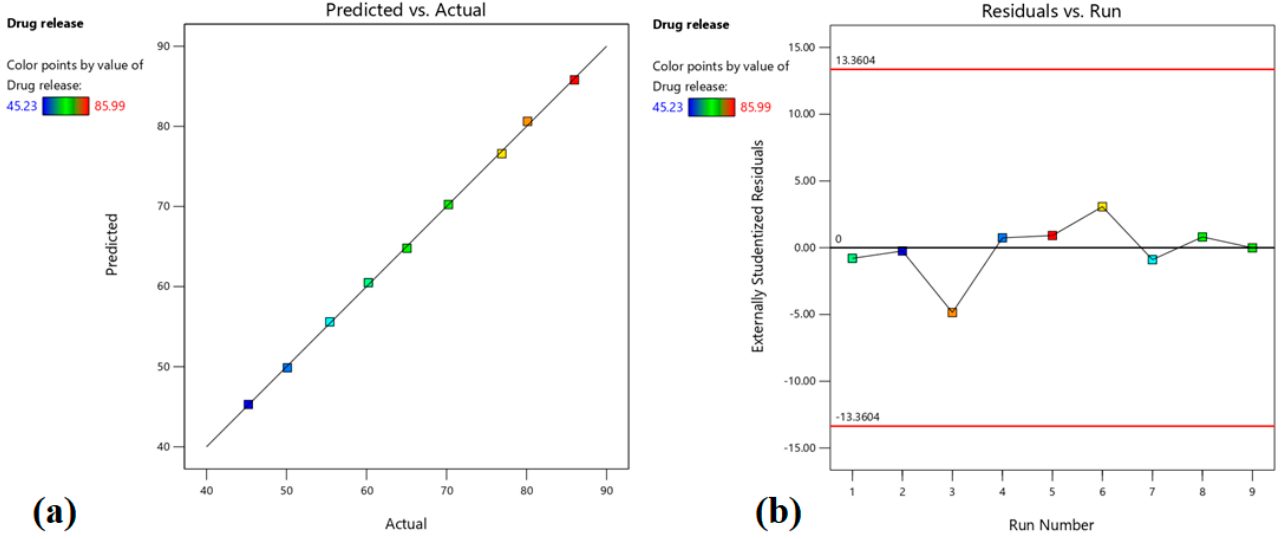
Figure 2. Linear correlation plot of predicted vs. actual ( a ) and related residual plot ( b ) on drug release.